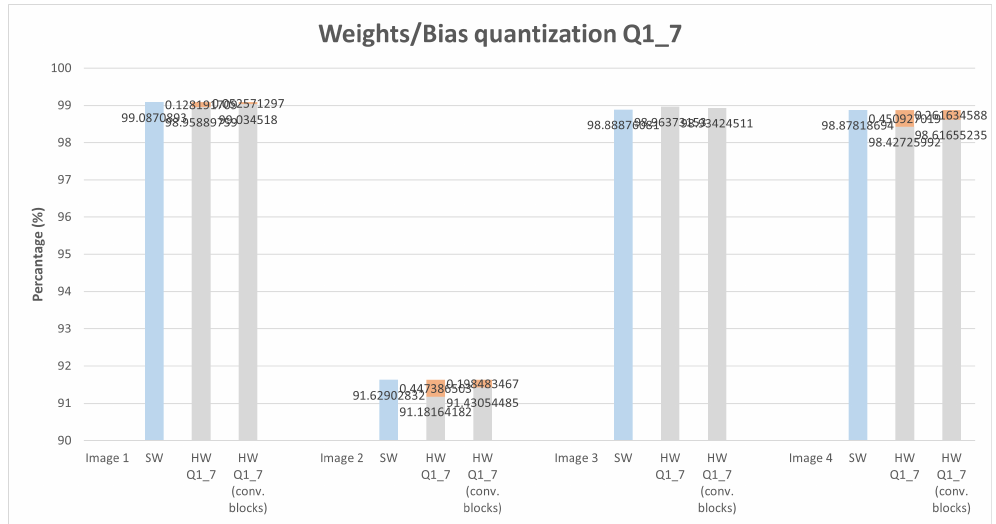
Figure 13. Weight and bias quantization for all MNIST model layers, and only for convolution layers with Q1_7. Blue bar provides SW data, grey quantized data and orange bar provides difference from SW_version and each quantized